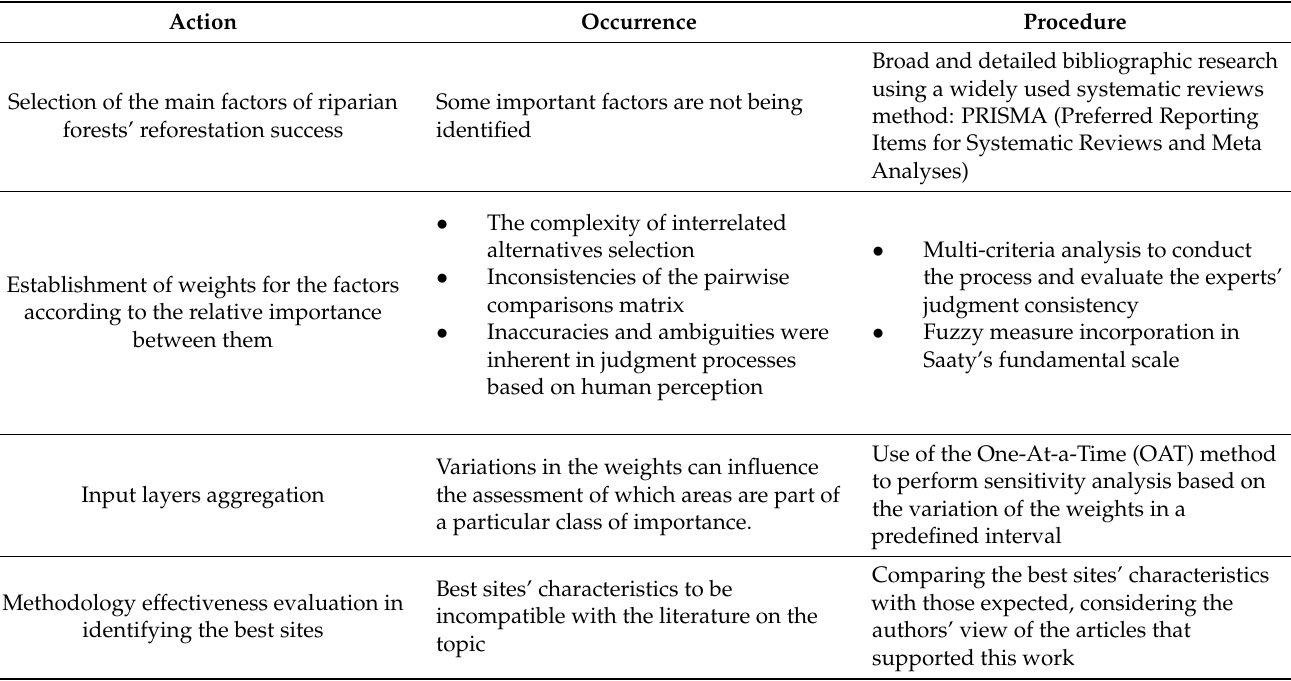
Table 1. Procedures used to increase the methodology